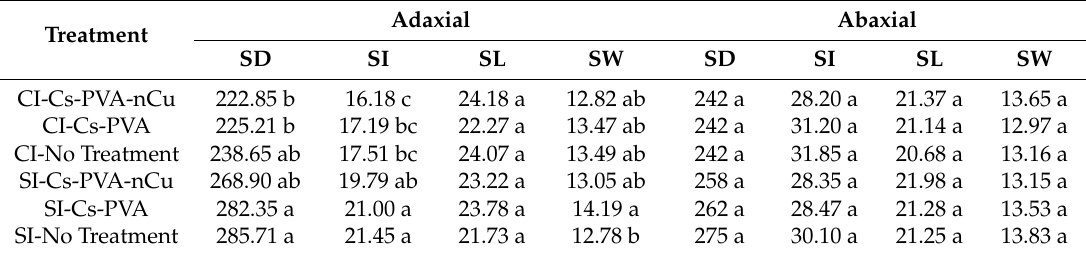
Table 8. Combined effect of grafting and application of gels on watermelon leaf micromorphology. Treatment